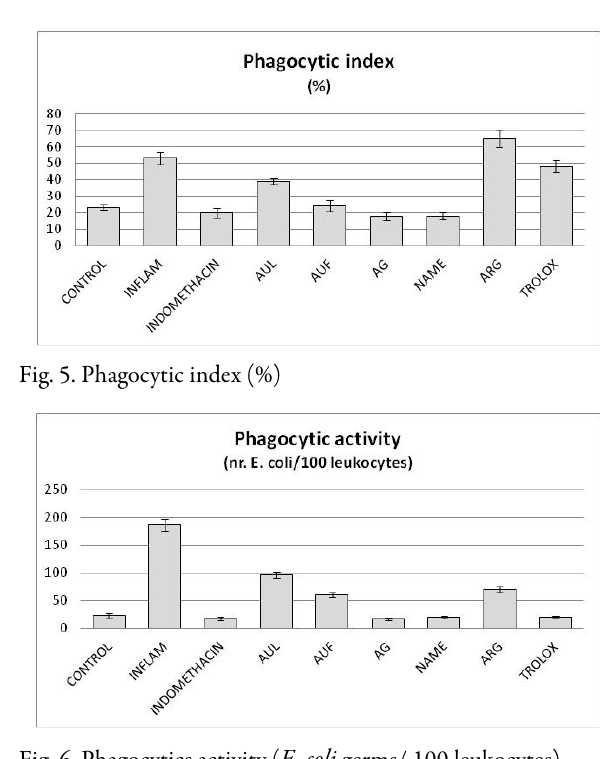
Fig. 6. Phagocytics activity ( E. coli germs/ 100 leukocytes)